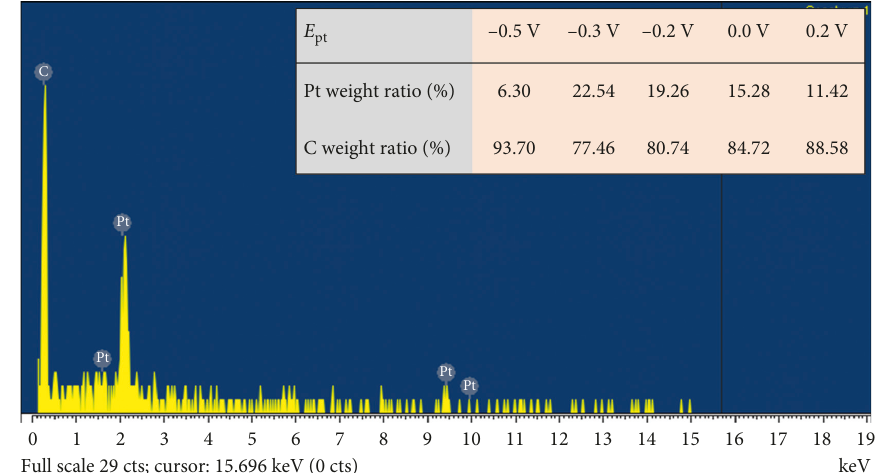
Figure 2: EDX spectra for the Pt/GCE prepared at the deposition potential of − 0.3V and the weight ratio of Pt element on the GCE at the different deposition potential ( E Pt ) (inset).